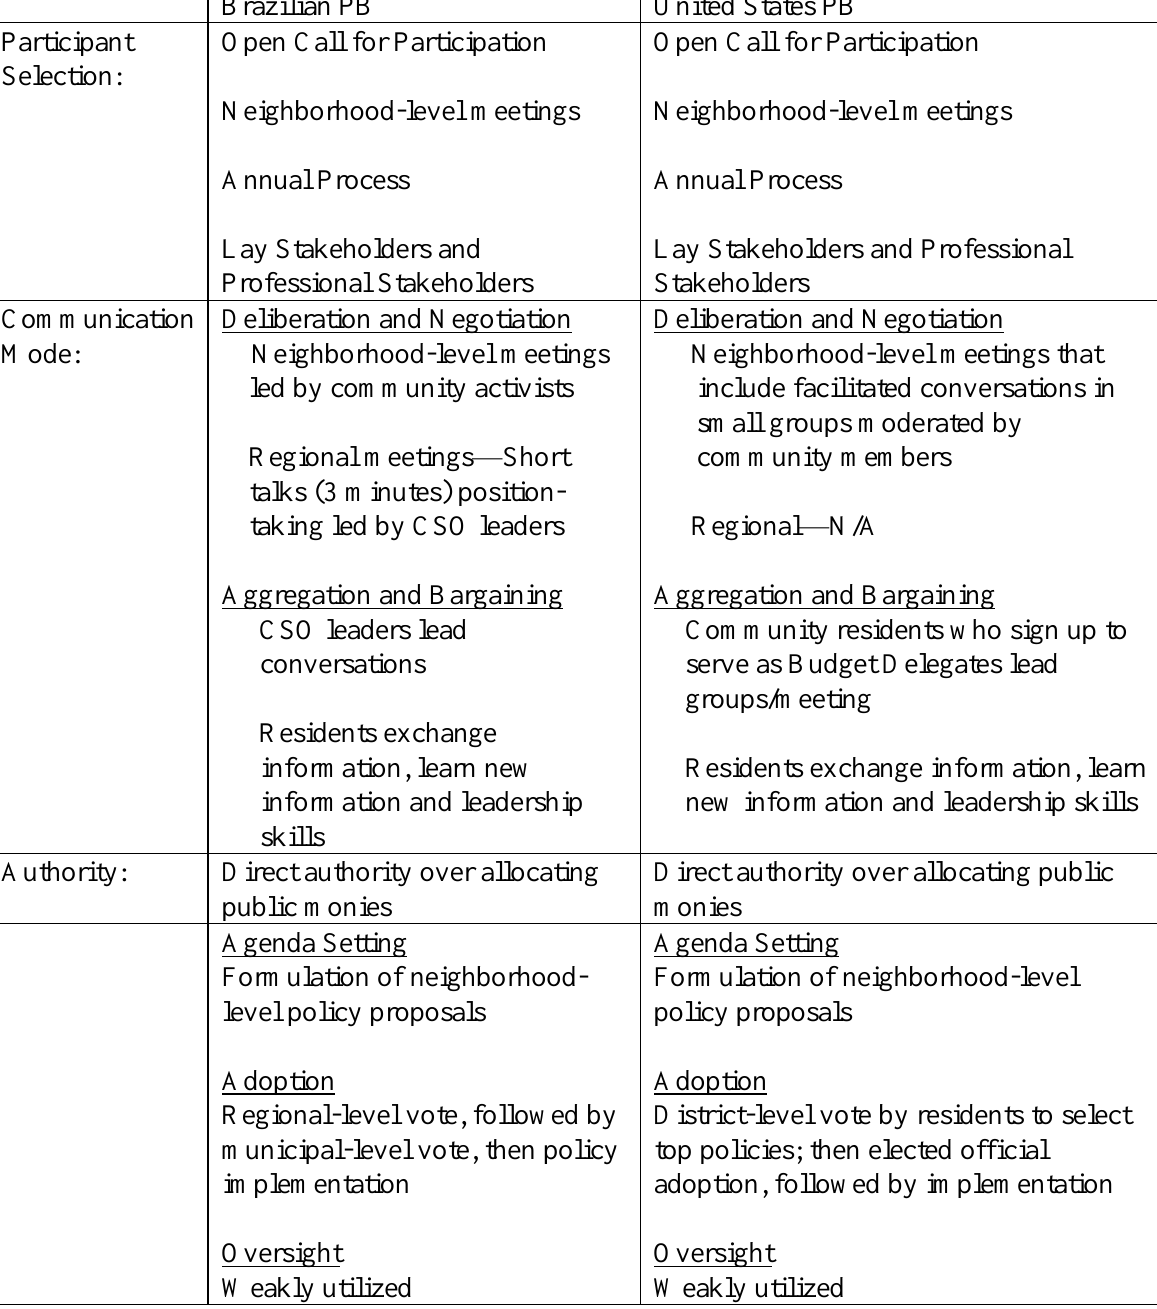
Key Similarities Between Brazilian and United States